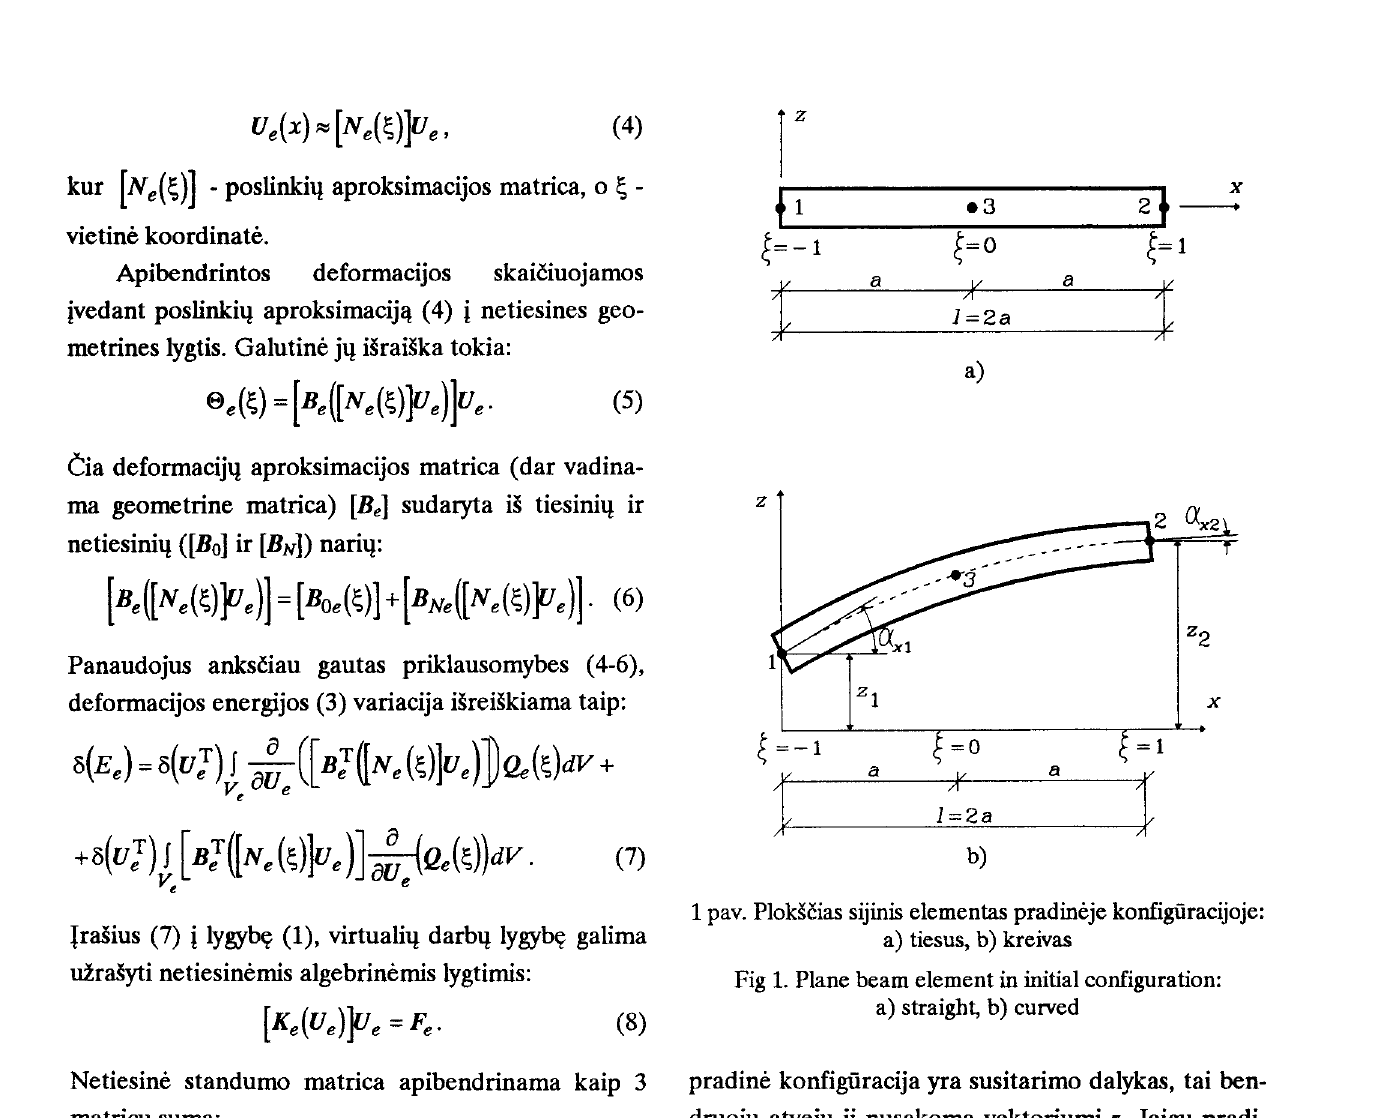
Fig 1. Plane beam element in initial configuration: a) straight, b) curved pradine konfigiiracija yra susitarimo dalykas, tai ben druoju atveju ji nusakoma vektoriumi z. Jeigu pradi neje konfigiiracijoje elementas yra tiesus, tai vekto rius z=O. Elemento fizikines savybes apraSomos dy dziais EA (tempiamo strypo standis) ir EI (lenkiamo strypo standis), kur E- tamprumo modulis, A - skers pjiivio plotas, I- skerspjiivio inercijos momentas. Baigtinis elementas turi 7 laisves laipsnius: po 3 (2 linijiniai ir vienas kampinis) elemento galuose ir 1 elemento viduryje (linijinis). Biitent vidurinis mazgas leidzia atsisakyti prielaidos, kad aSine jega per vis~ strypo ilgi nekinta. Mazgq poslinkiq vektorius Ue siam elementui isskaidomas i dvi dalis: U e = { u, w'} T, cia vektorius = { u u 1, u 2, U:3} T apraso horizontalius poslinkius. Pos linkis u 3 apraSo vidurinio strypo mazgo poslinkj, kurio priklausomybe nuo galiniq mazgq poslinkiq nera tiesine. Tiksliau kalbant, u yra nuokrypa nuo tiesinio 3